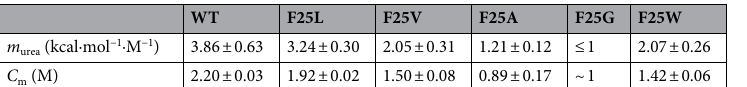
Table 4. Apparent denaturation equilibrium parameters with urea at 25 °C determined by Far-UV CD. C m and m urea values were retrieved from fittings of experiments shown in Fig. 5. For F25G, we could only obtained reasonable fittings when C m or m urea values were fixed, and thus some gross estimation was only